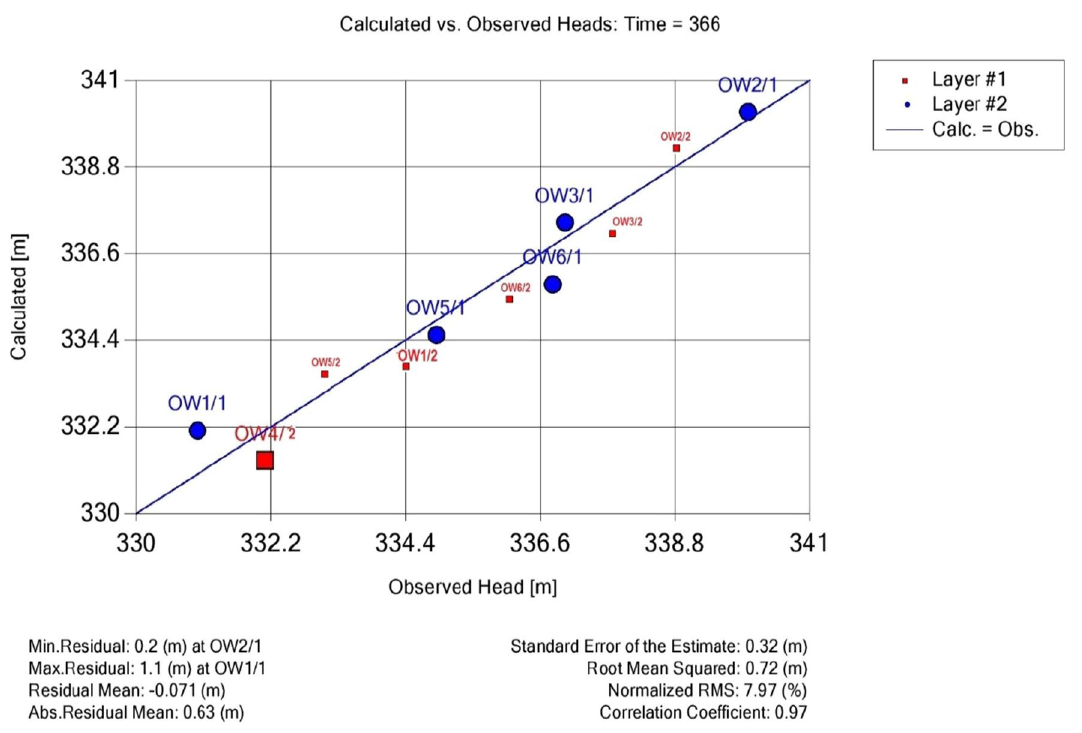
Fig. 15 Calculated vs observed head using numerical modelling